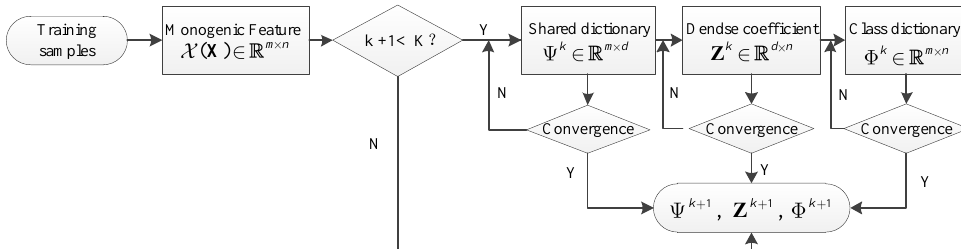
Figure 3. The flow diagram of low-rank dictionary learning. The objective function can be solved by three sub-optimization procedures. The variables Φ , Ψ , and Z are alternately updated by minimizing the sub-optimization problems. When the termination condition is met, the solution of the objective function is